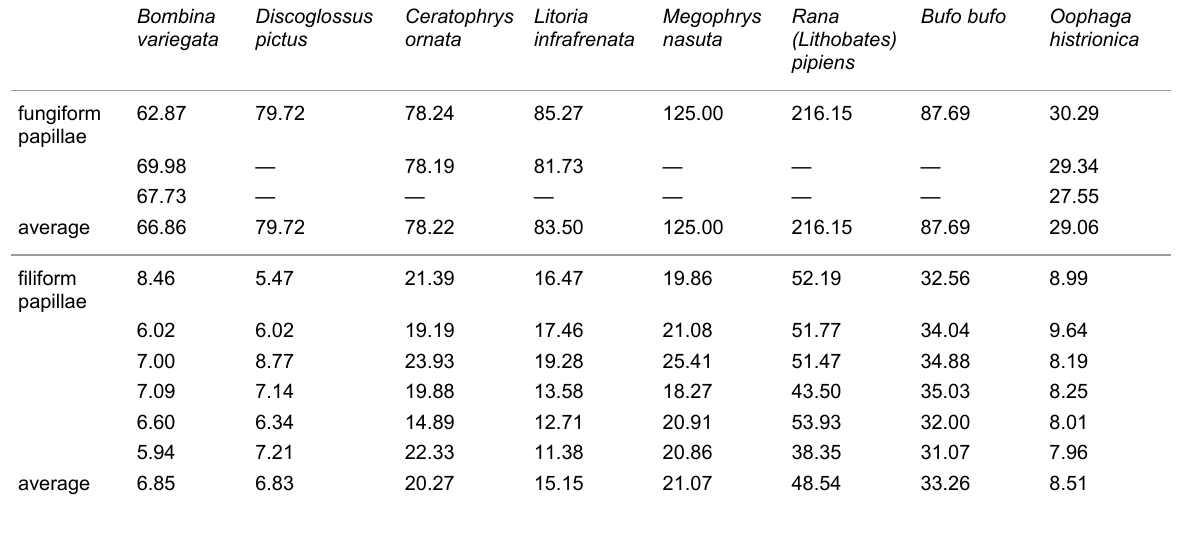
Table 2: Measurements of tongue papillae in micrometers based on Figure 1. Bombina variegata